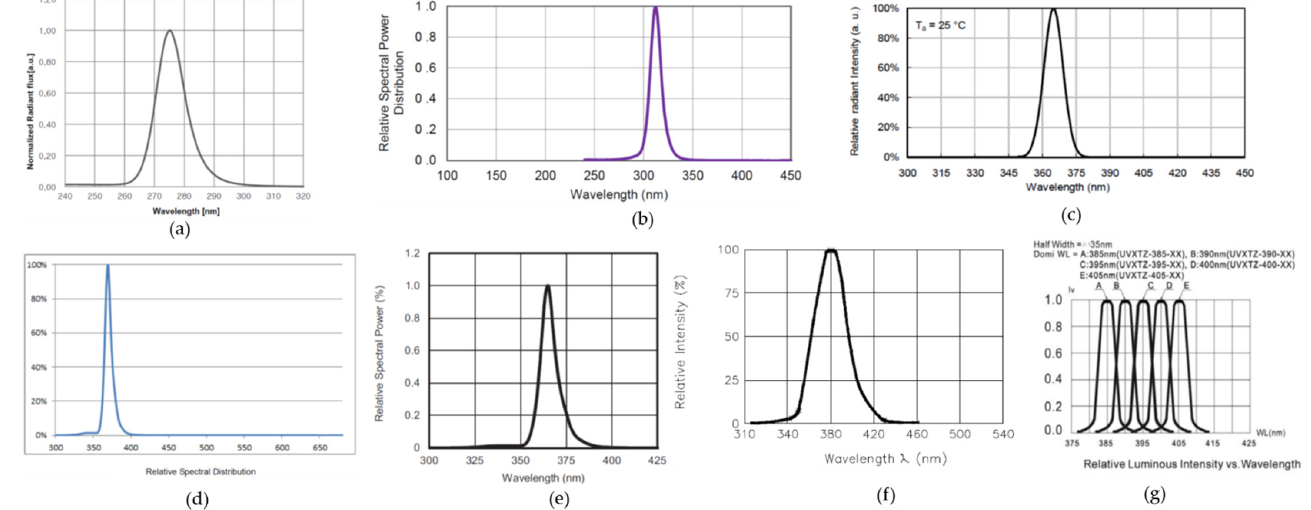
Figure 6. Optical spectrum emission of the seven UV LEDs from the calibrator device: ( a ) #1 (CUD7QF1A); ( b ) #2 (PB2D-UCLA-KB); ( c ) #3 (ATS2012UV365); ( d ) #4 (LTPL-C034UVH365); ( e ) #5 (VLMU1610-365-135); ( f ) #6 (VAOL-5GUV8T4); ( g ) #7 (UV5TZ-395-30). (All the graphs were obtained from the manufacturer’s datasheet).